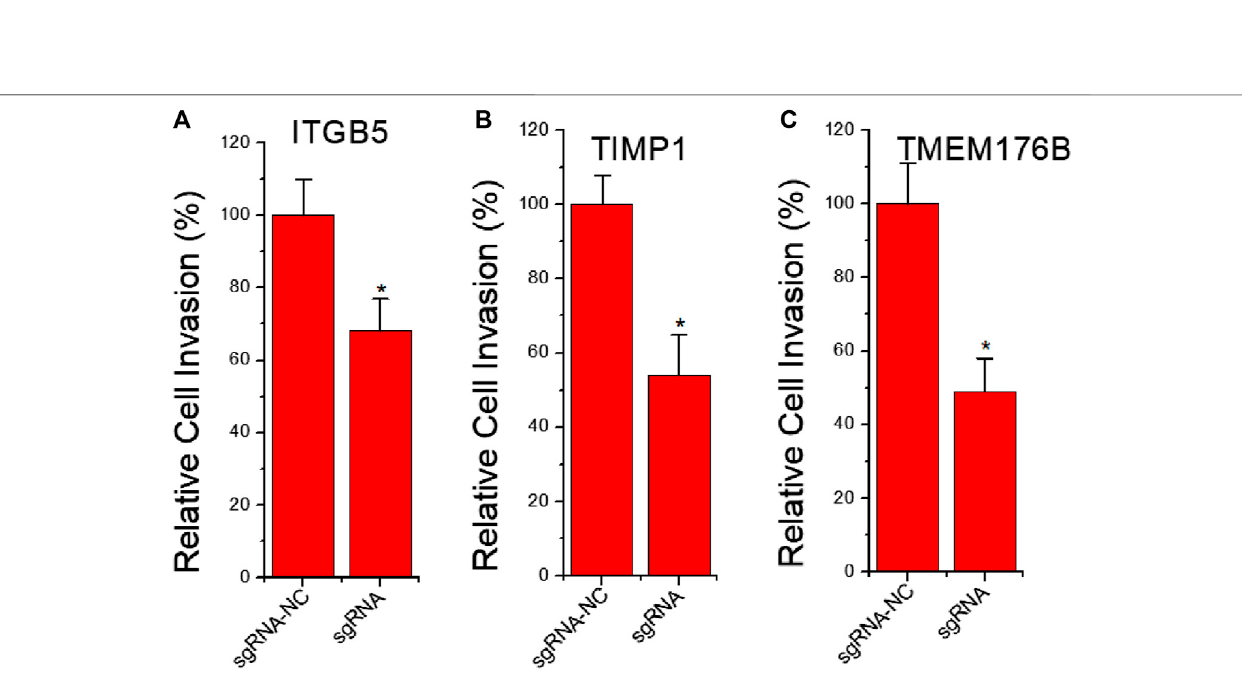
( Figure 2A ) to knock down the expression of ITGB5 ( Figure 2B ), and used dCas9-VPR-mediated CRISPRa technology ( Figure 2A ) to activate TIMP1 and TMEM176B expression ( Figure 2B ). The experimental results of MTT show that inhibiting the expression of ITGB5 can reduce cell proliferation, while activating the expression of